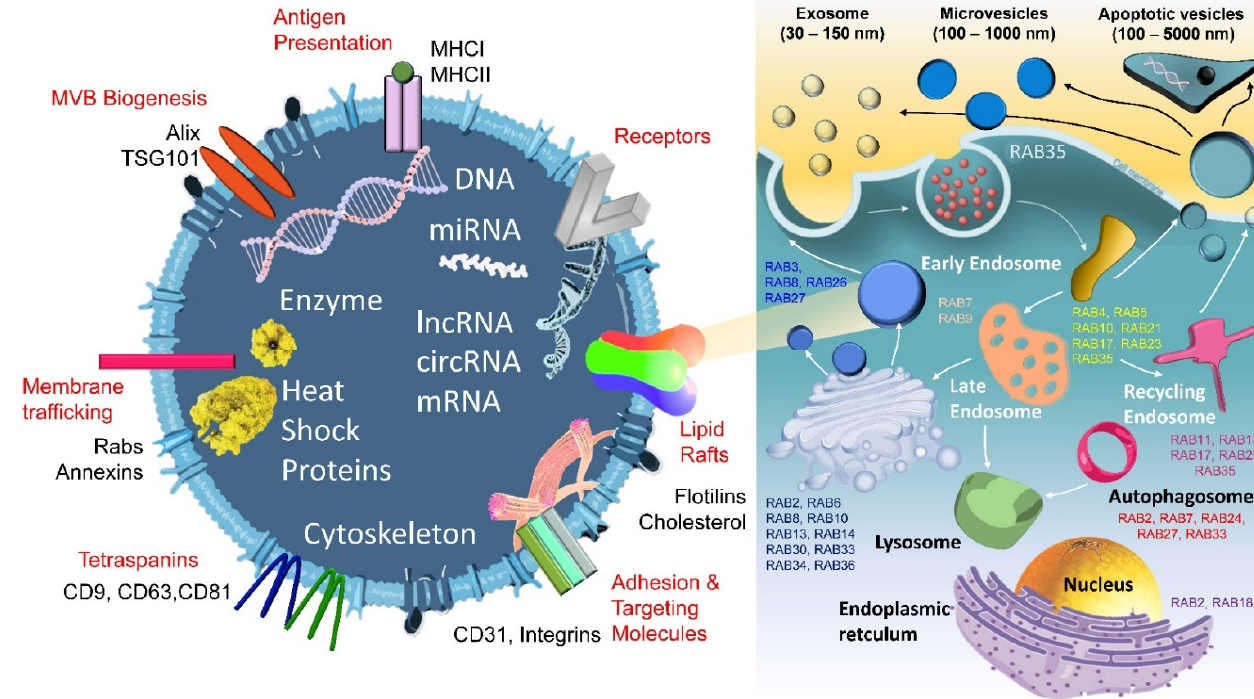
Figure 1. The classification of extracellular vesicles (EVs), the process of exocytosis, and components of EVs . Members of the RAB family regulate different EVs (early/late endosome, recycling endosome, autophagosome, etc.). EVs embed various substances and anchor receptors and factors on the membrane.